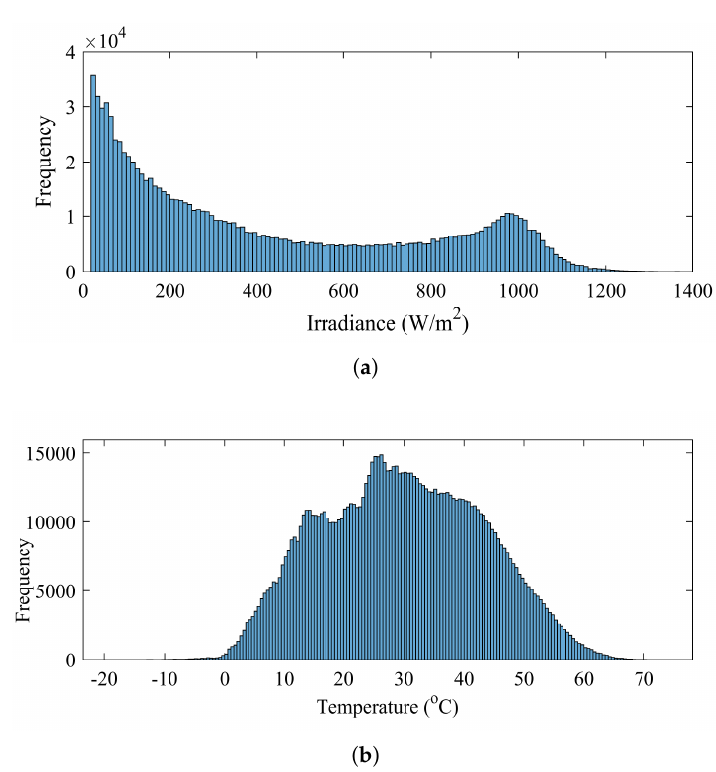
Figure 3. Histograms of ( a ) irradiance and ( b ) temperature distribution of the study-case